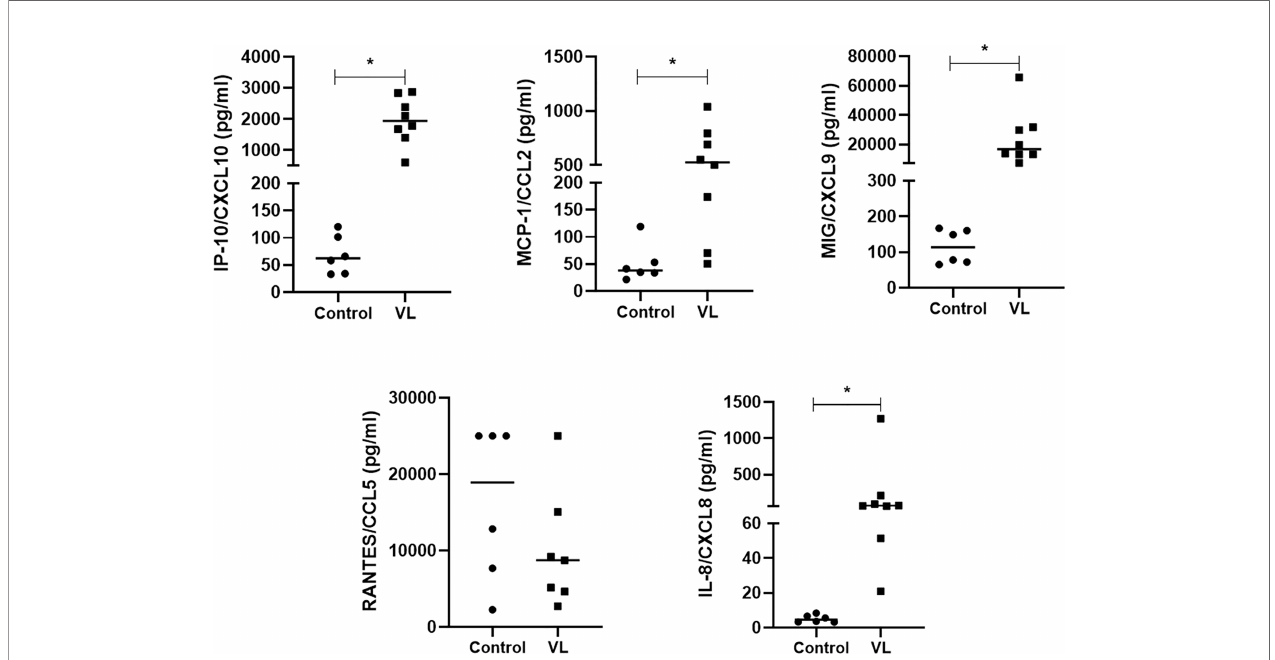
FIGURE 6 | Chemokines in plasma of active VL patients and controls. IP-10/CXCL10, MCP1/CCL2, MIG/CXCL9, RANTES/CXCL5, and IL-8/CXCL8 concentrations were measured in the CBA kit using fl ow-cytometry. Data are shown as pg/mL, and each symbol corresponds to one subject * = p <0.05 (Mann-Whitney test). Patients (N=8) and controls